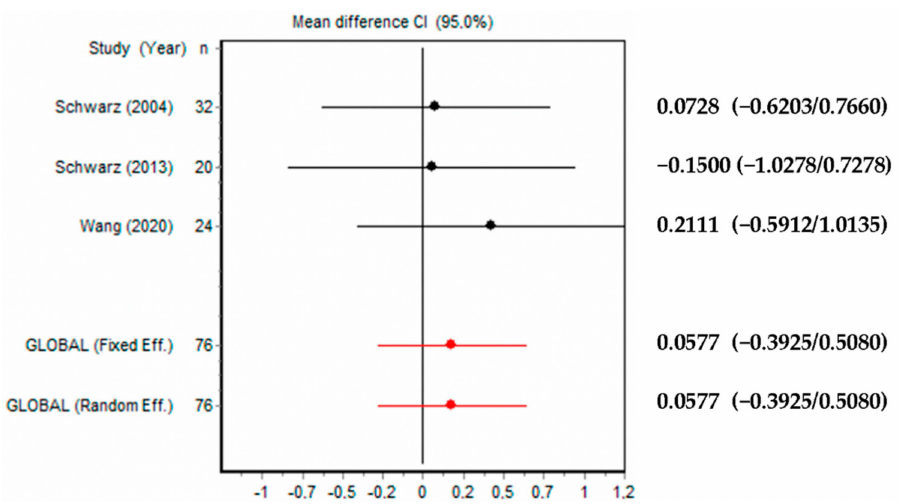
Figure 3. Forest Plot for PPD reduction mean after treatment (Er:YAG laser vs. conventional mechanical